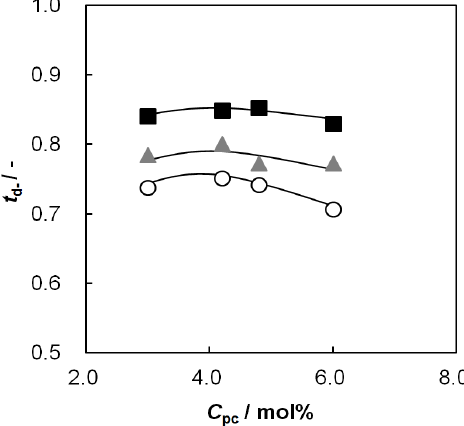
Figure 6. Dynamic state transport number, t percentage of the anion-exchange groups, C the same as in Figure 2.